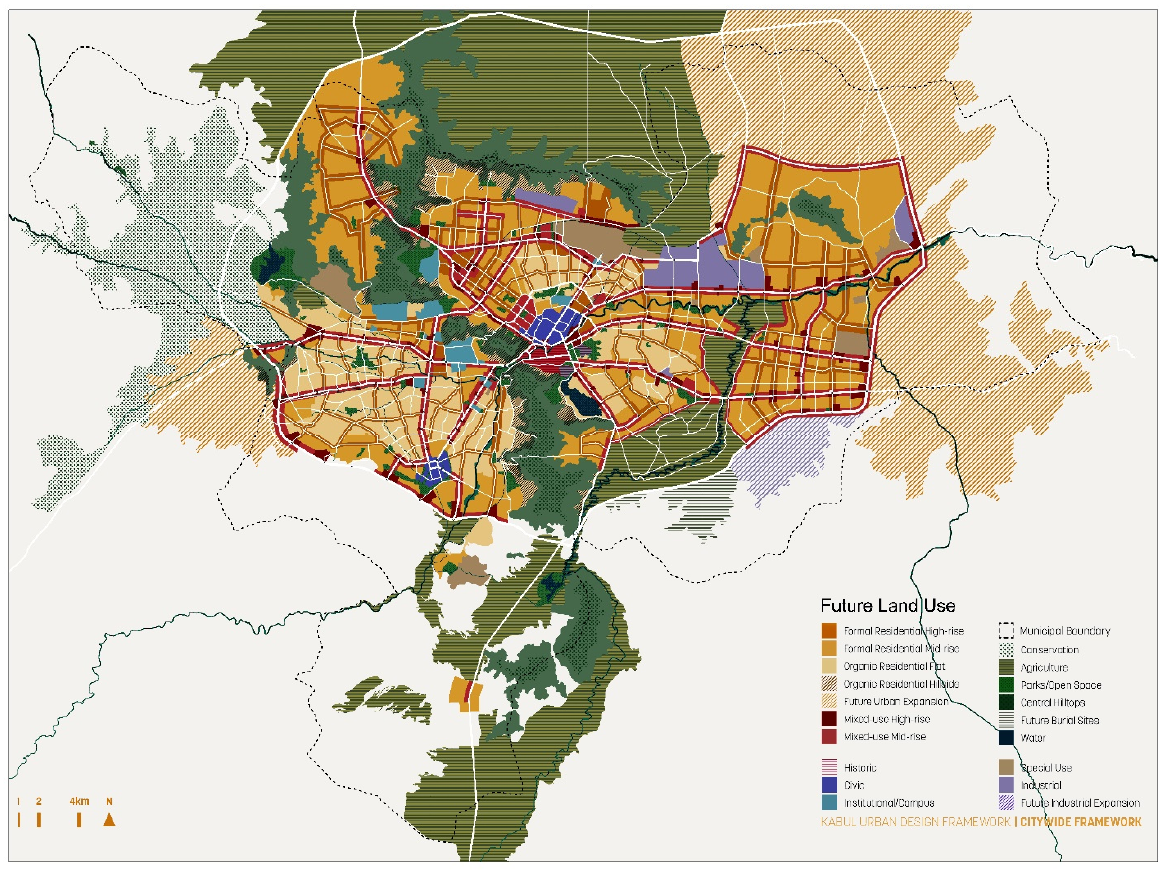
Figure 2. Kabul City Master Plans through the years: ( a ) First Master Plan of Kabul, 1964 (Calogero 2011); ( b ) Second Master Plan of Kabul, 1970 (Calogero 2011); ( c ) Third Kabul Master Plan (Calogero 2011), 1978; ( d ) Japan International Cooperation Agency (JICA) Master Plan, 2011; ( e ) Kabul Urban Design Framework (KUDF) 2018, Sasaki, Inc. Table 1. Master plans of Kabul.